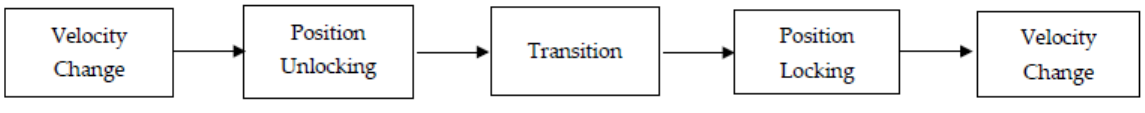
Figure 12. Proposed morphing